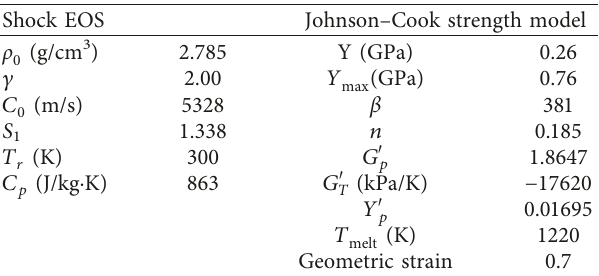
Table 5: Material parameters of 2024-T4 aluminum. Shock